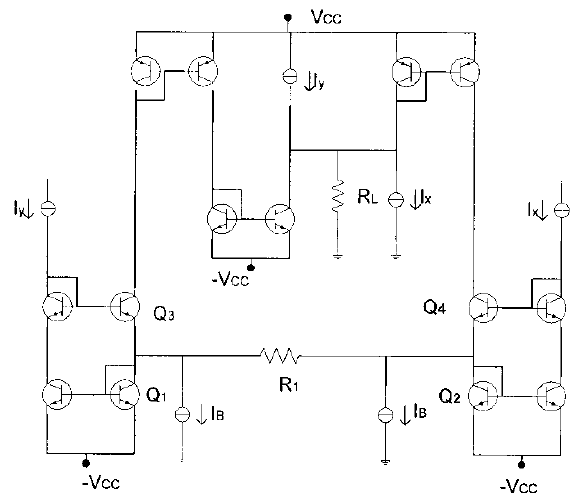
FIGURE 1 Proposed logarithmic